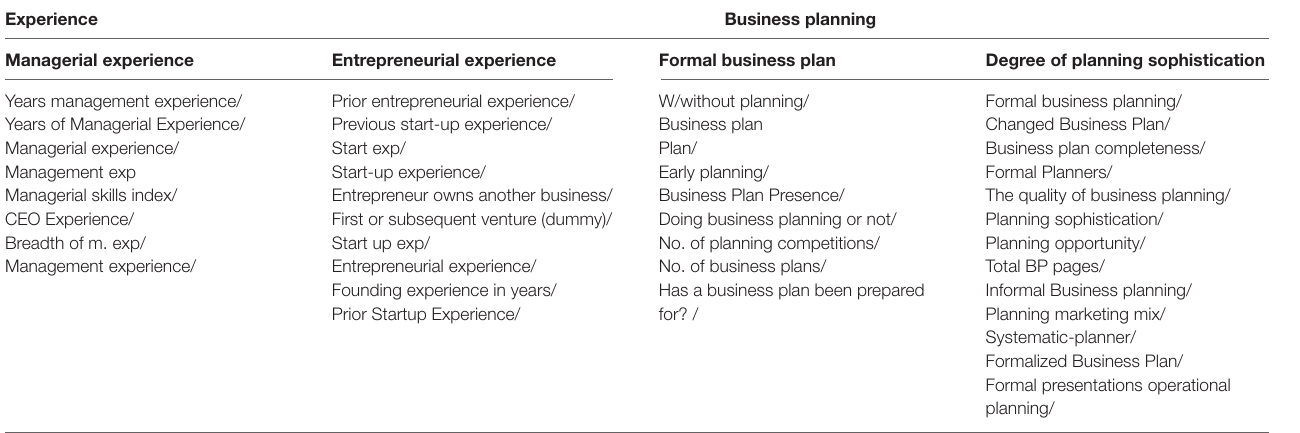
TABLE 1 | Definitions of study